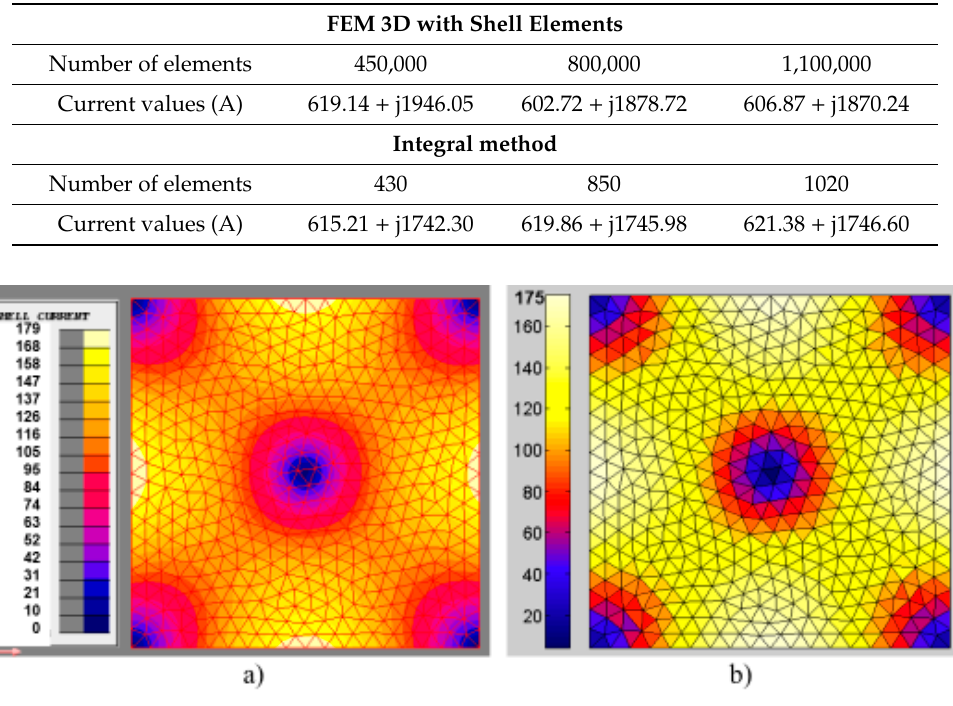
Figure 8. Surface distribution of the current (A/m) in the thin shell for the test case “Folies”: ( a ) FEM 3D with shell elements; ( b ) Integral method. Table 2. Current values in the passive loop, where j is an imaginary unit.